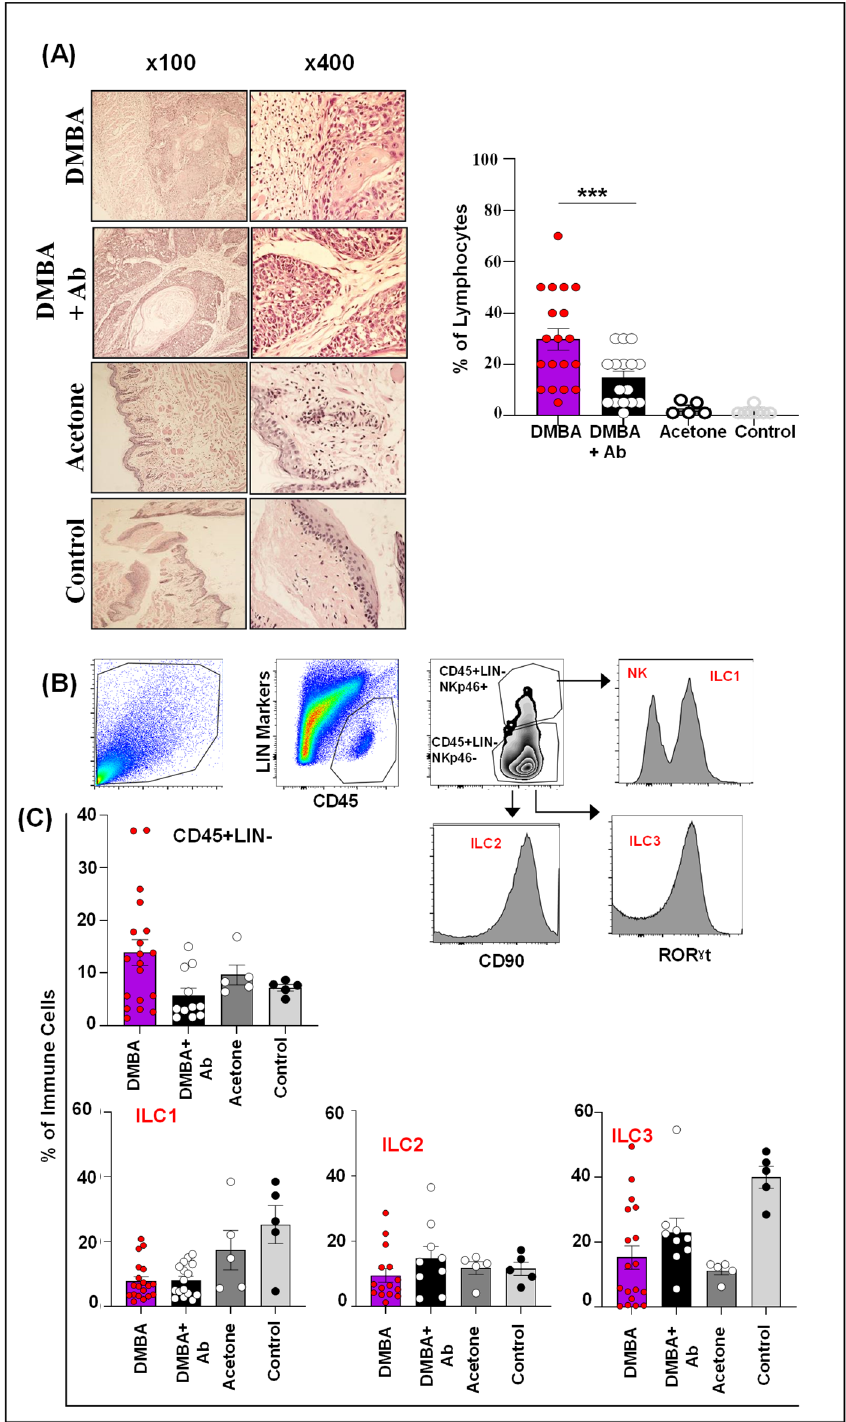
Figure 3. Expression of lymphocytes and ILC population in murine OSCC. ( A ) Representative H & E images of lymphocyte infiltration in DMBA, DMBA+Ab, acetone, and control groups at 100x and 400x magnification. Increased infiltration of lymphocytes in DMBA and DMBA+Ab group mice compared to mice in the acetone and control groups. Lymphocytic infiltration was significantly higher in DMBA group mice compared to DMBA+Ab group mice ( p < 0.05). ( B ) Gating strategy for ILC1, ILC2, and ILC3. ( C ) Increased infiltration of CD45+LIN- cells in DMBA group mice. ILC1 and ILC3 were significantly decreased in DMBA and DMBA+Ab mice groups compared to control mice, while the ILC2 infiltrate was not significantly different amongst various mice groups. DMBA = 7,12-dimethylbenz[a]anthracene; DMBA+Ab = 7,12-dimethylbenz[a]anthracene+antibody. *** p <